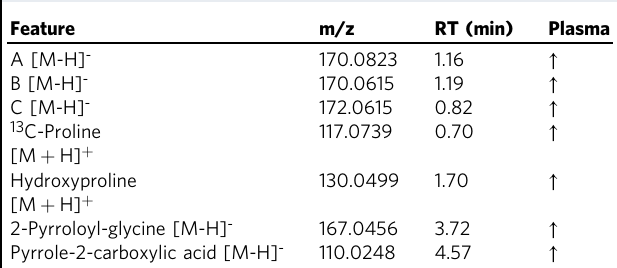
Table 1 Identi fi ed features by untargeted metabolomics in HPII body fl